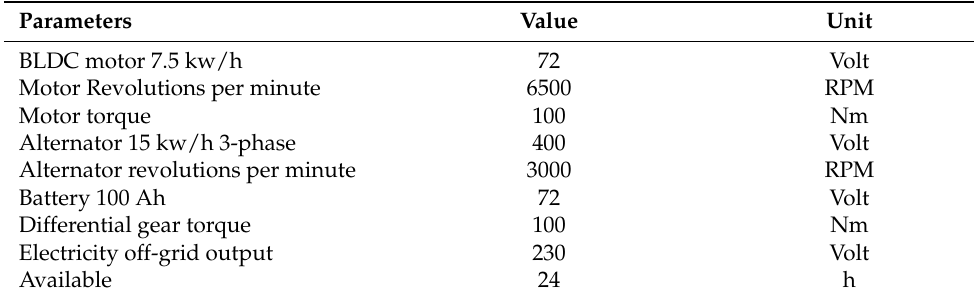
Table 6. Circulation of electric power